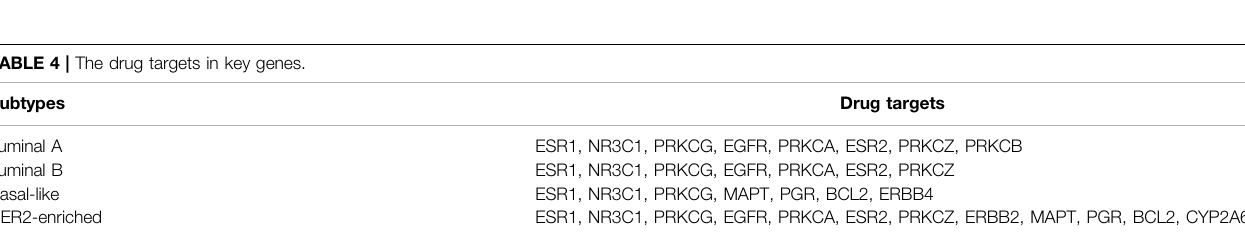
TABLE 4 | The drug targets in key